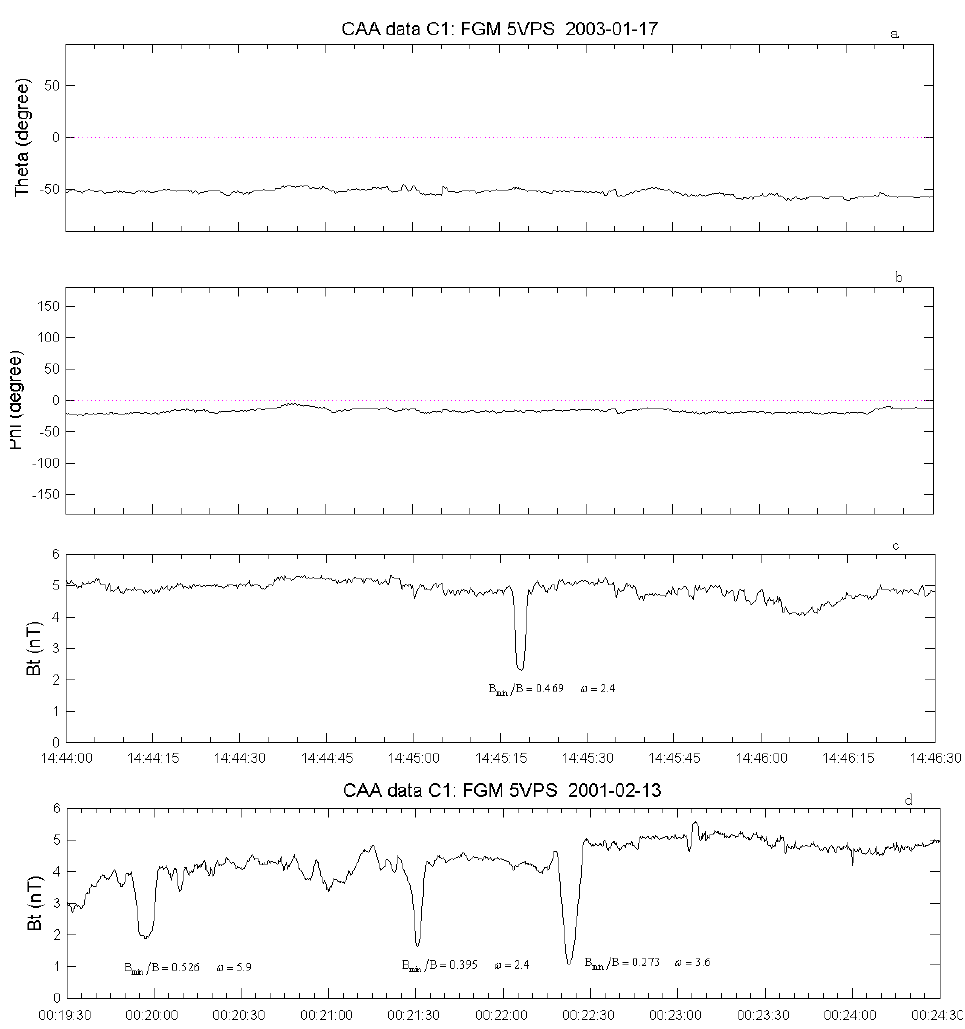
Fig. 1. (a)–(c) A typical example of a single magnetic hole in the solar wind observed by Cluster C1, (a) the polar angle, (b) the azimuthal Figure 1. (a)-(c) A typical example of a single magnetic hole in the solar wind observed by 416 angle (c) the field magnitude. (d) The field magnitude of a magnetic hole train with 3 magnetic holes in Cluster C1, (a) the polar angle, (b) the azimuthal angle (c) the field magnitude. (d) The field 417 magnitude of a magnetic hole train with 3 magnetic holes in 300s. 418